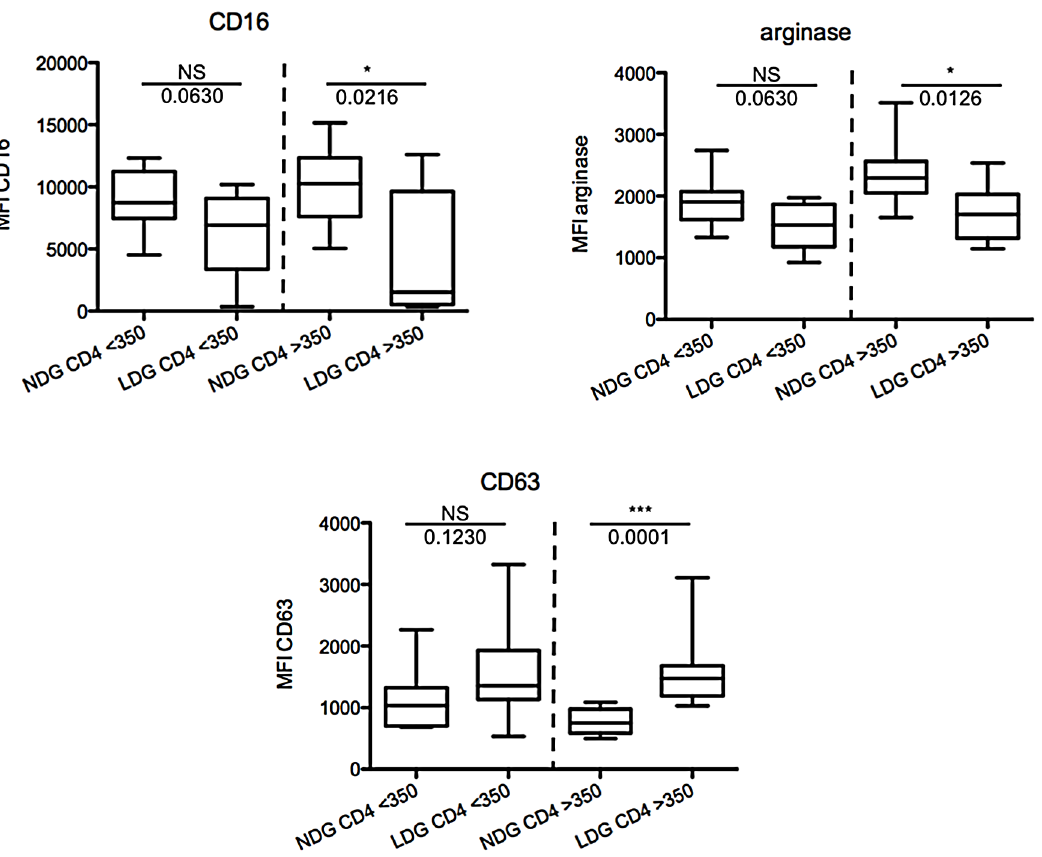
Figure 4. Phenotypes of NDGs and LDGs in CD4low and CD4high HIV + patients. PBMCs and NDGs were isolated from the blood of HIV + patients with CD4 + T cell counts . 350 (n=11) or , 350 cells/ m L (n=10) as described in materials and methods and the expression levels of phenotypic markers were determined by flow cytometry. Isotype controls: , 1%. Statistical significance was determined by a two-tailed Mann- Whitney test. Box=interquartile range and median; whiskers=range.